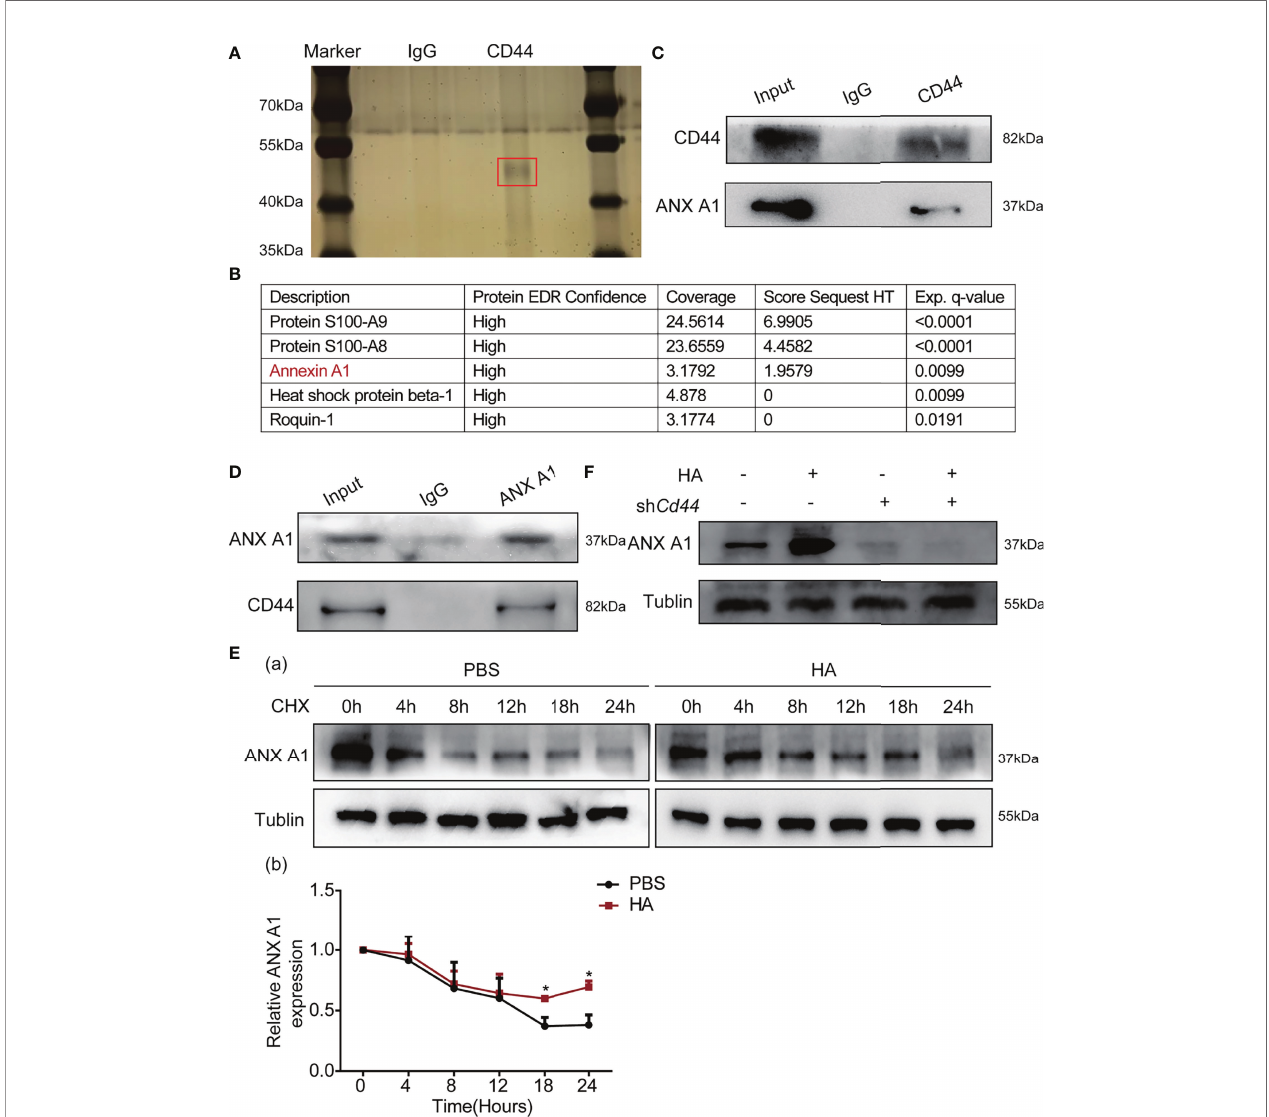
FIGURE 5 | HA/CD44 axis promoted the expression and the stability of ANX A1 at the protein level. (A) Silver staining detected related proteins compared with red marker showing the differential band. (B) The results of mass spectrometry. (C) WB assay veri fi ed that HA/CD44 directly interacted with ANX A1. (D) WB assay veri fi ed that the interaction between ANX A1 and CD44 at the protein level through pulling-down ANX A1. (E) The stability of ANX A1 with or without CHX in the in vitro Th1 cells differentiation experiment with or without the existence of HA was detected by WB assay (a, the protein bands and b, corresponding data analysis according to data in a). (F) The expression of ANX A1 in the in vitro Th1 cells differentiation experiment with or without the existence of HA was detected by WB assay. *p <